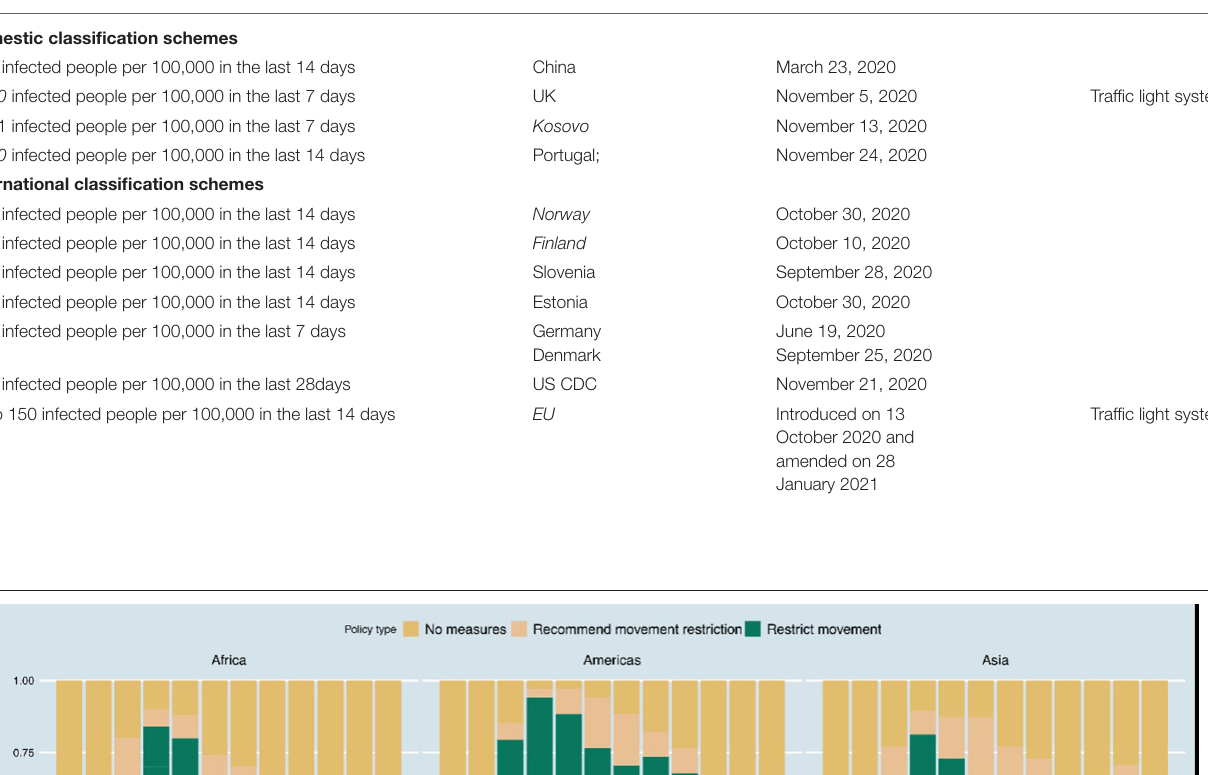
TABLE 1 | Summary of different types of high-risk areas classification scheme.